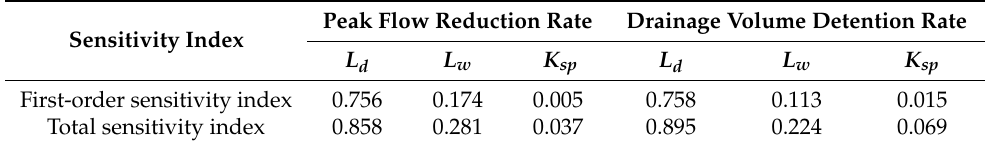
Table 1. Sensitivity indices of influencing parameters of off-line ditch-pond system with respect to peak flow reduction rate and drainage volume detention